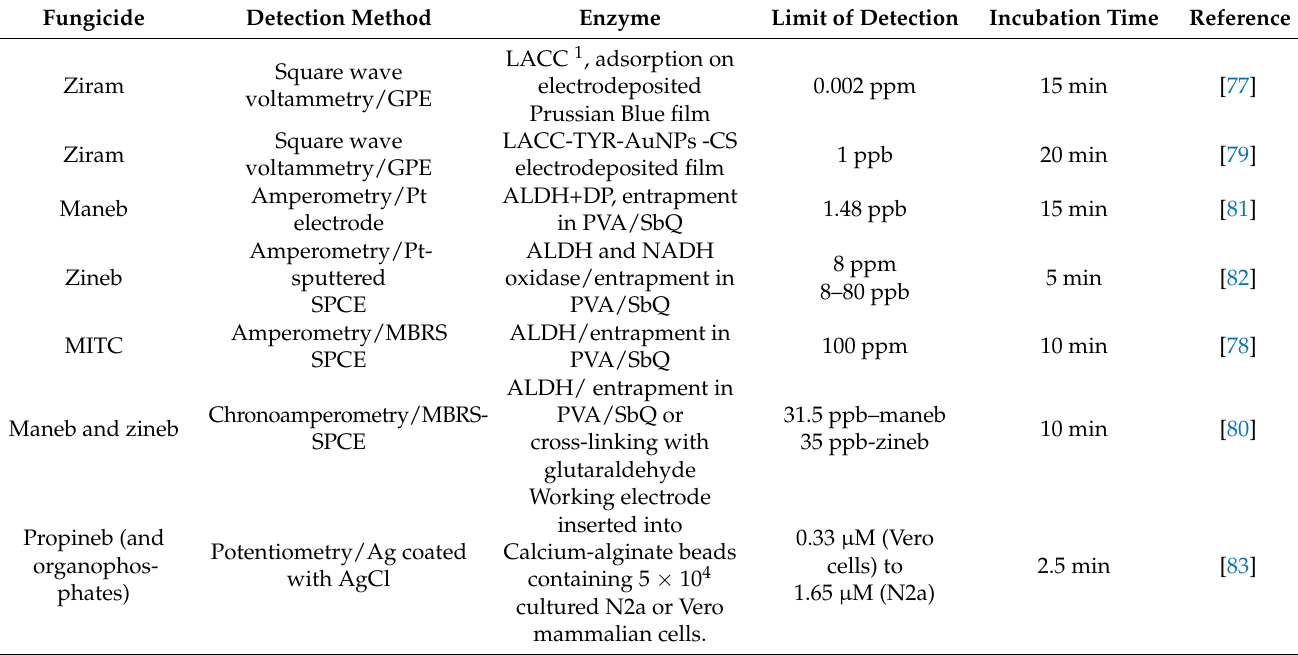
Table 3. Examples of biosensors for DTF based on enzymatic